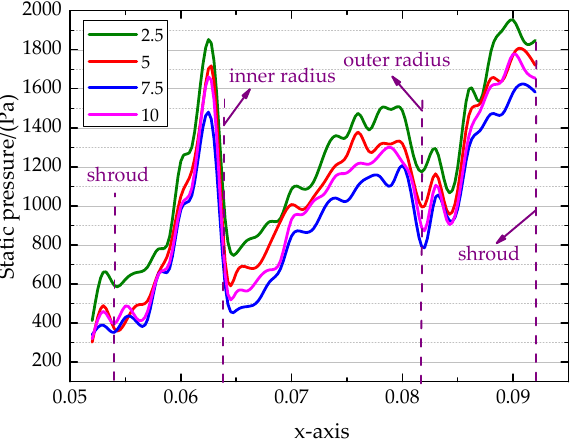
Figure 13. Change rules of static pressure along the x -axis under di ff erent values of the distance c 1